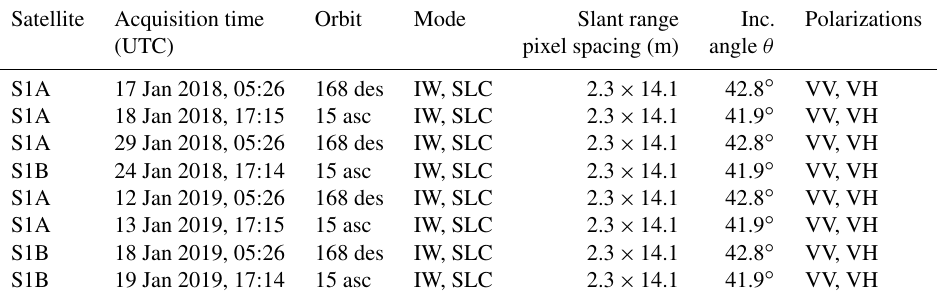
Table 2. Properties of the Sentinel-1 radar acquisitions. Satellite Acquisition time